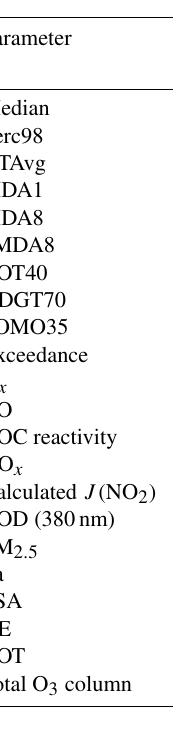
Table 2. p values of temporal trends for different